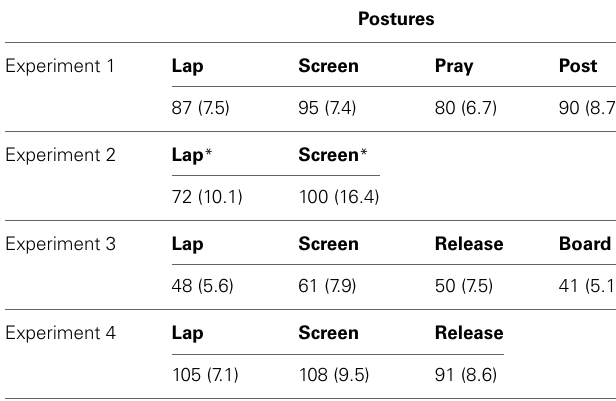
Table 1 | Mean set size differences (mean response times for setsize 8–setsize 4) and corresponding standard errors in parentheses for the postures of Experiments 1–4.